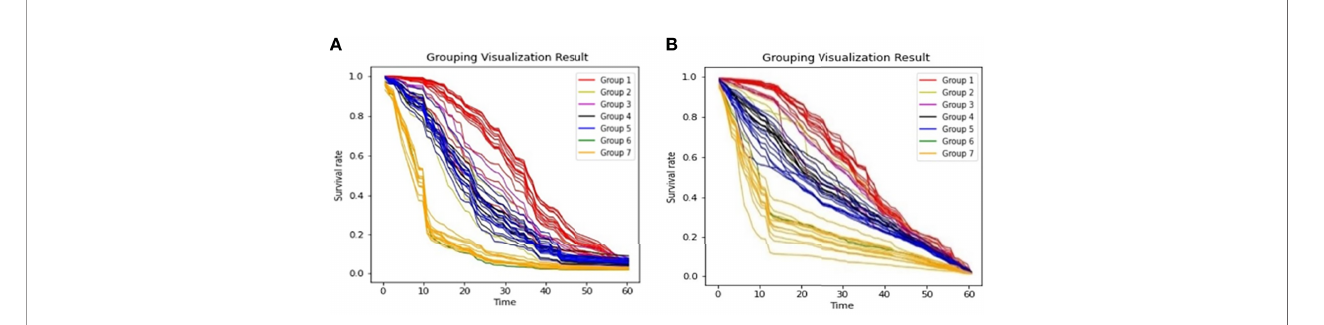
FIGURE 5 | Survival Curves by Maintenance Schema (A) . Grouping Visualization Result of RSF; (B) . Grouping Visualization Result